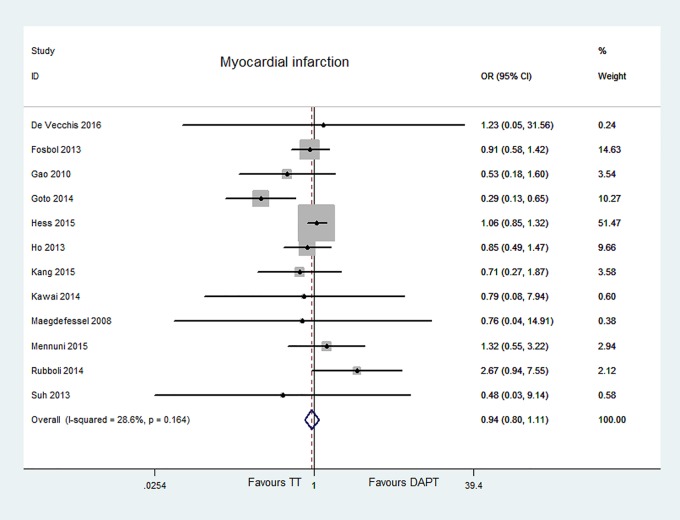
Forest plot of MI in patients with and DAPT.